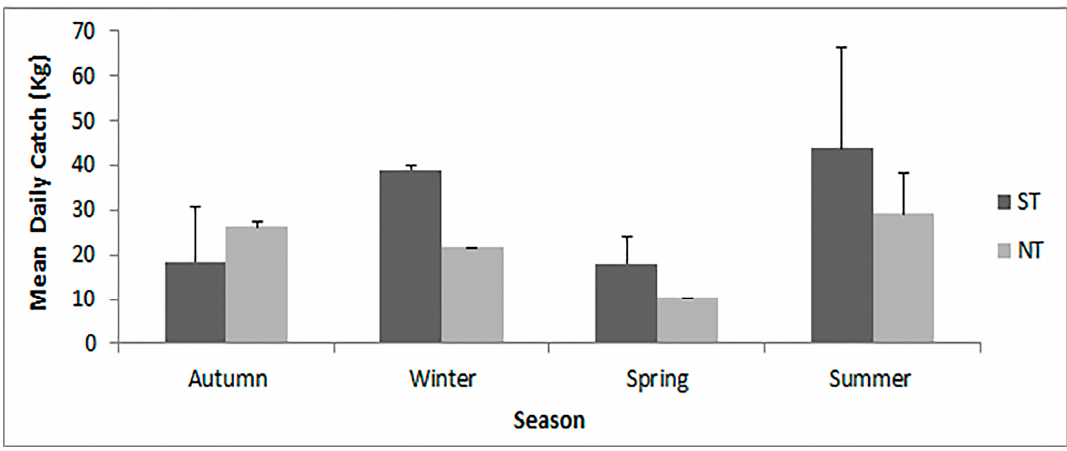
Figure 2. Mean Catch (kg) of casulo as a function of individuals practicing digging in Aveiro lagoon on a daily basis for the surveying period 2012–2013.